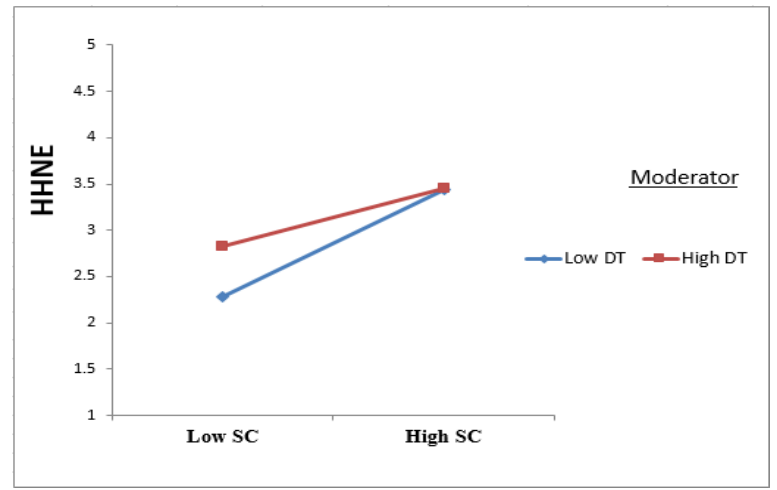
Figure 3. Interaction plot for the DT moderation effect on SC towards HHNE.